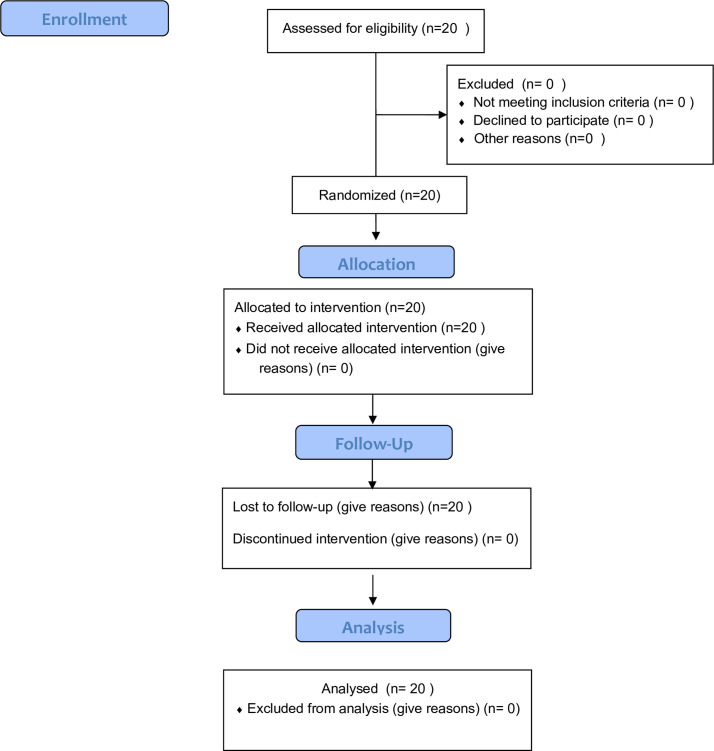
CONSORT flowchart.